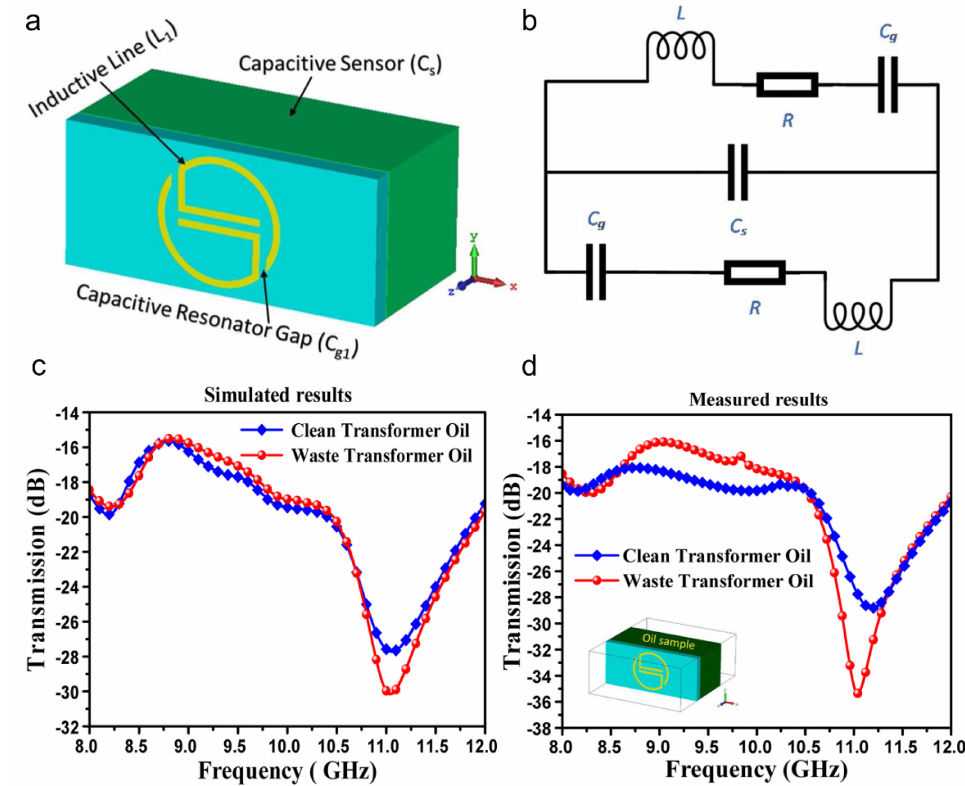
Figure 11. ( a ) Design of the inductive and capacitive components in the proposed structure. ( b ) Equiv- alent circuit diagram of the proposed metamaterial-based sensor. ( c ) Simulation and ( d ) experimental transmission spectra in response to clean and waste transformer oils [127] Copyright © 2022 Else- vier